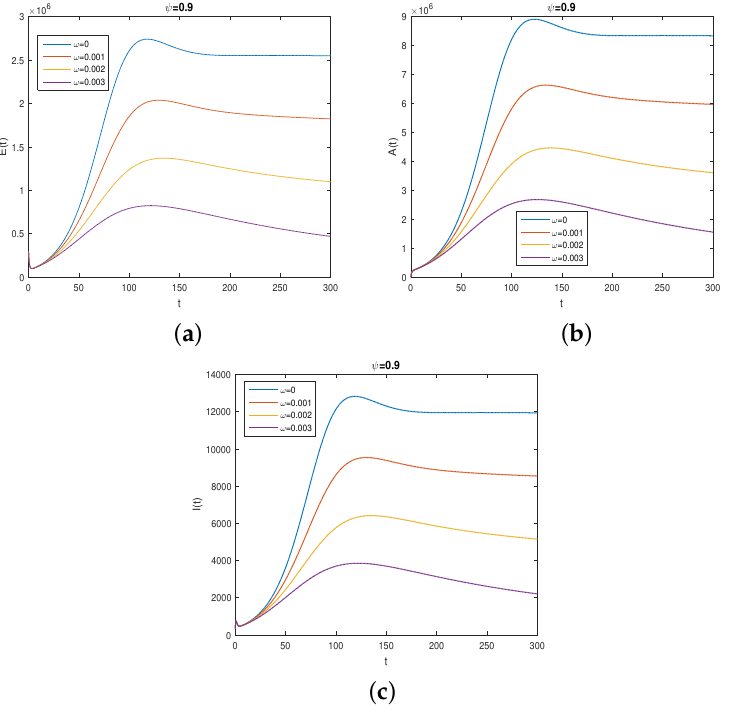
Figure 7. Impact of the vaccination rate on the model components for different values of ω and more effective efficacy, ψ = 0.9 and η = 0.95. Subfigures ( a – c ) describe the dynamics of exposed, asymptomatic, and symptomatic individuals